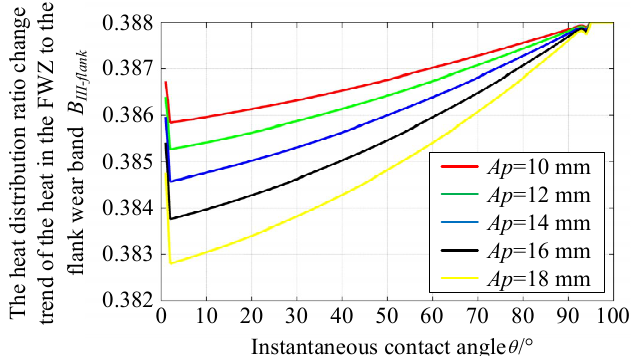
Figure 24. Heat distribution ratio of the heat source in the FWZ to the wear band on the flank of end mills at different milling speeds ( Ap = 10 mm).